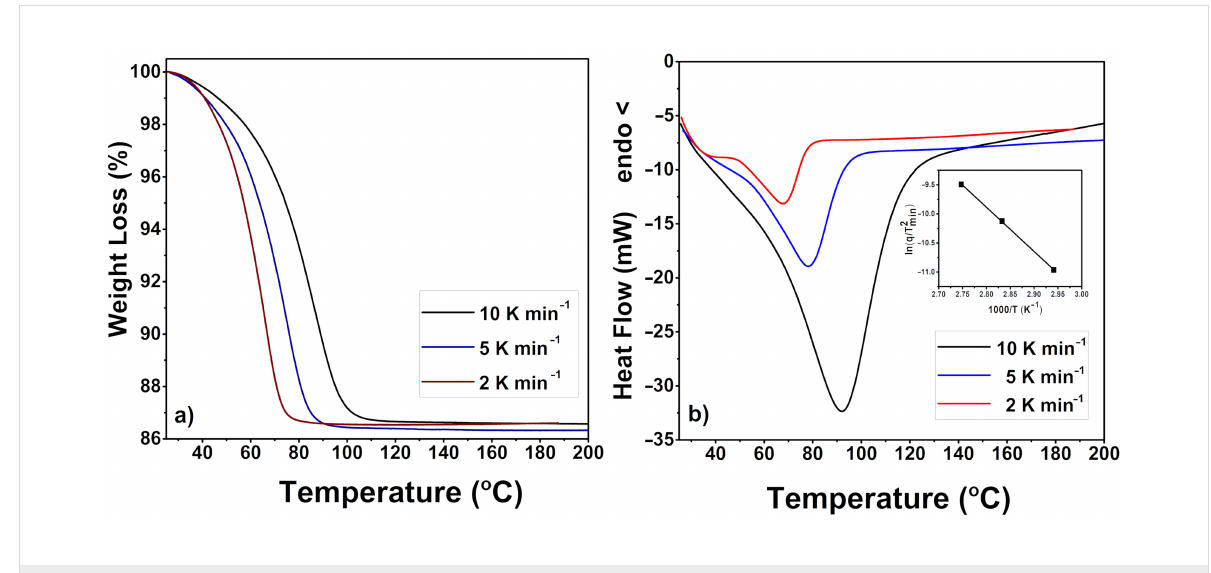
Figure 6: Thermal behavior of β -CD: TG curves (a) and DTA scans (b).